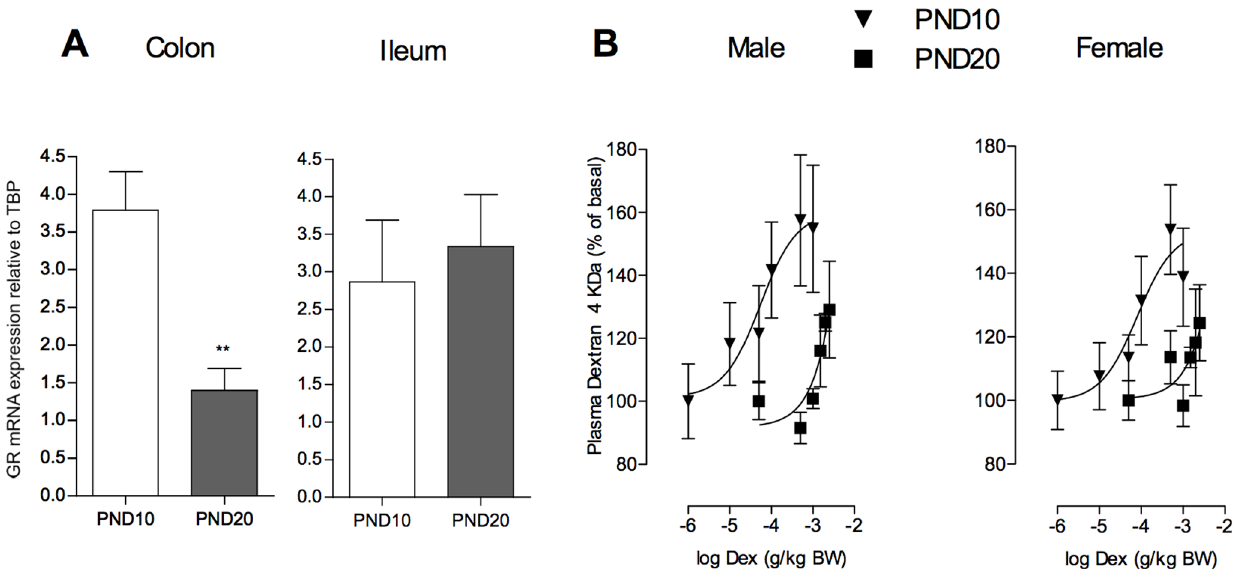
Figure 5. Dose-response study of DEX on IP to FD4 and GR expression in the small intestine and the colon. (A) qPCR results for GR mRNA using total RNA from colon and ileum lysates of PND10 and PND20 female rat pups. (B) Total in vivo IP to Dextran 4 kDa (FD4) was measured following subcutaneous injections of Dex (0.01 mg to 2.5 mg (kg BW) 2 1 for 1 day) at PND10 or PND20. In both sexes, note the decreased sensitivity to GC receptor stimulation evoking IP increase to FD4 at PND20 compared to PND10. Data are expressed as the mean 6 SEM (n=3–10 pups per group).